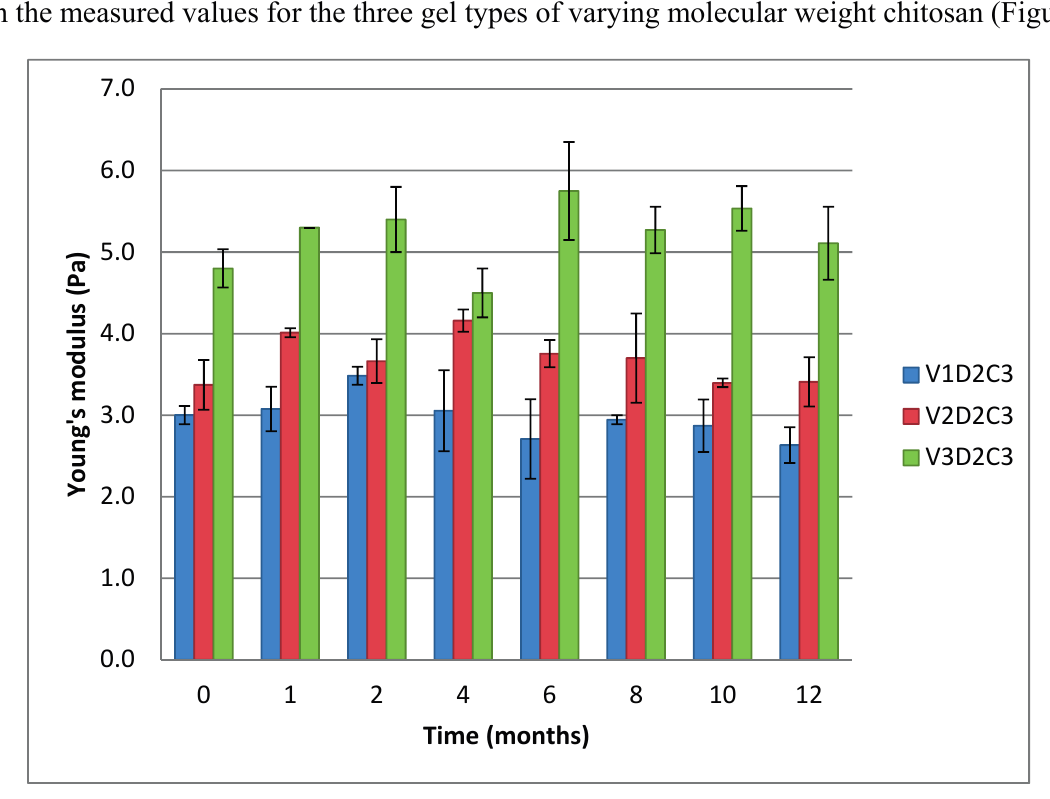
Figure 7. Comparison of Young’s modulus over 12 months for cylindrical gels of 1% ( w / w ) chitosan of variable molecular weight at 3% theoretical DES